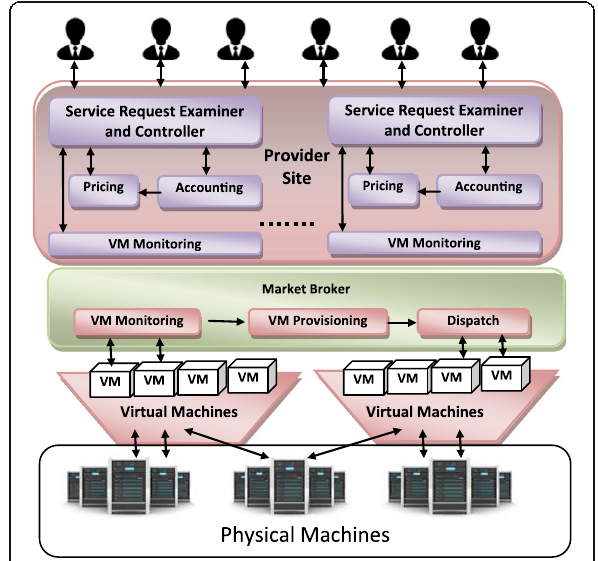
Fig. 2 High Level Architecture of the Cooperative Cloud Market